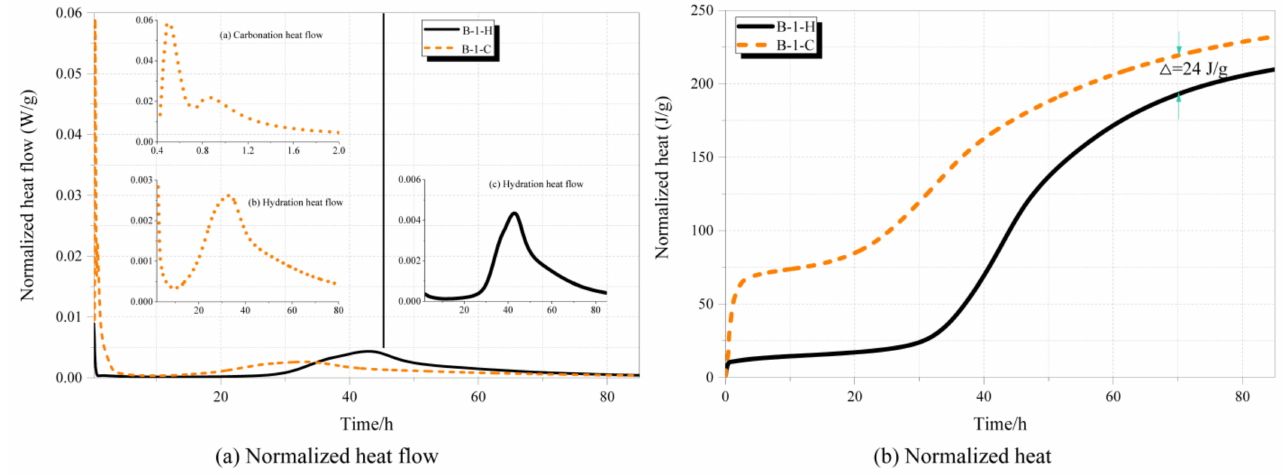
Figure 8. Normalized carbonation–hydration heat flow ( a ) and normalized heat ( b ) of B-1